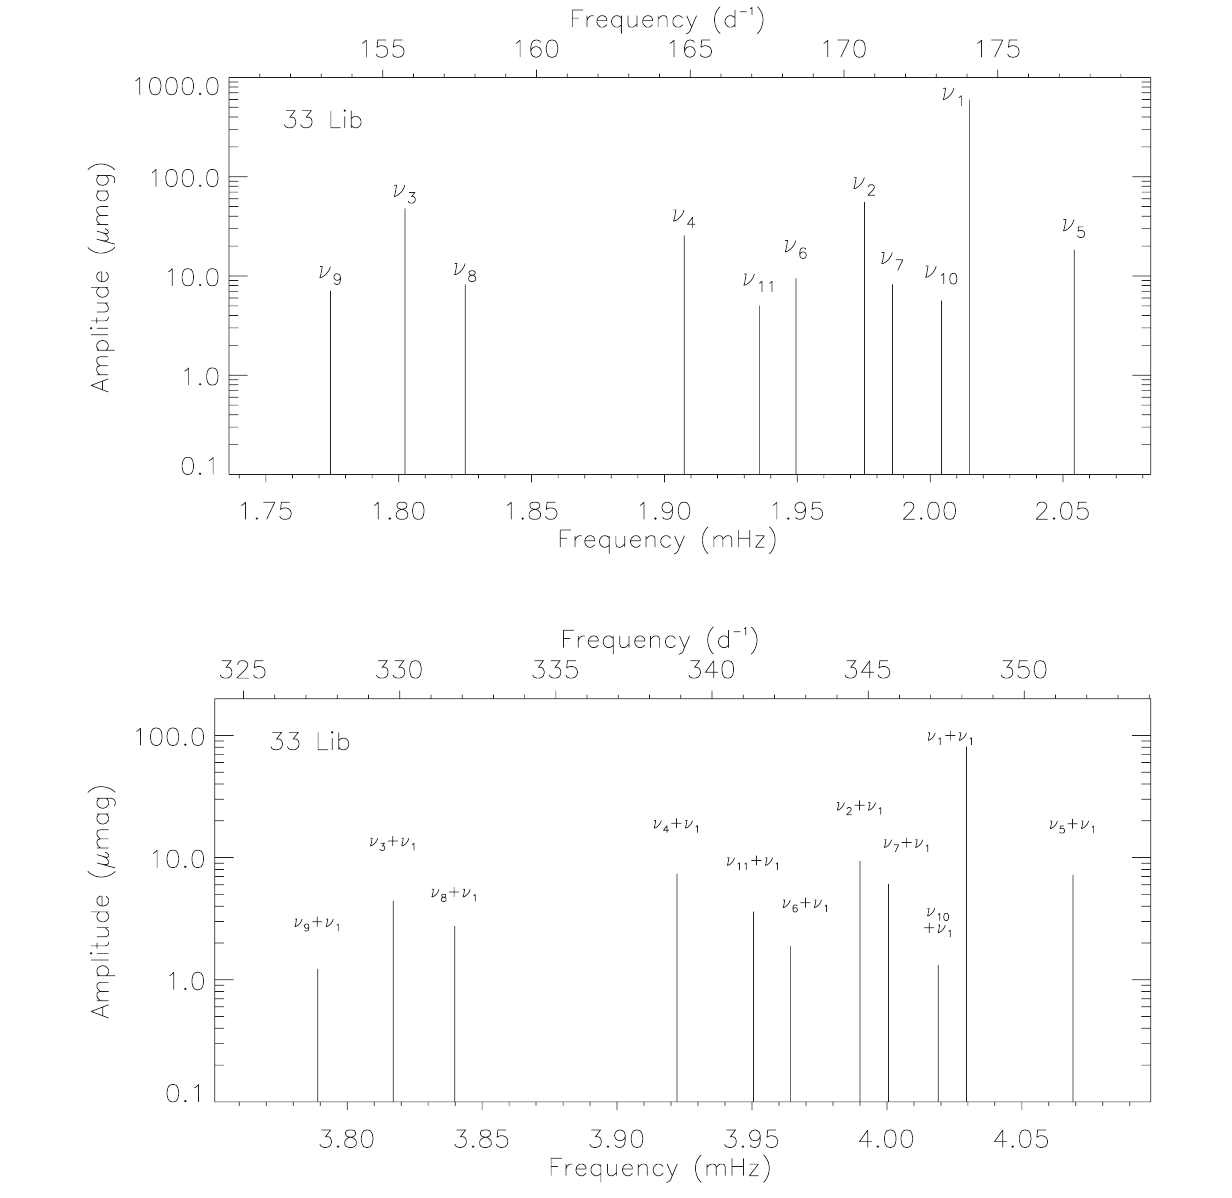
Frontiers in Astronomy and Space Sciences |